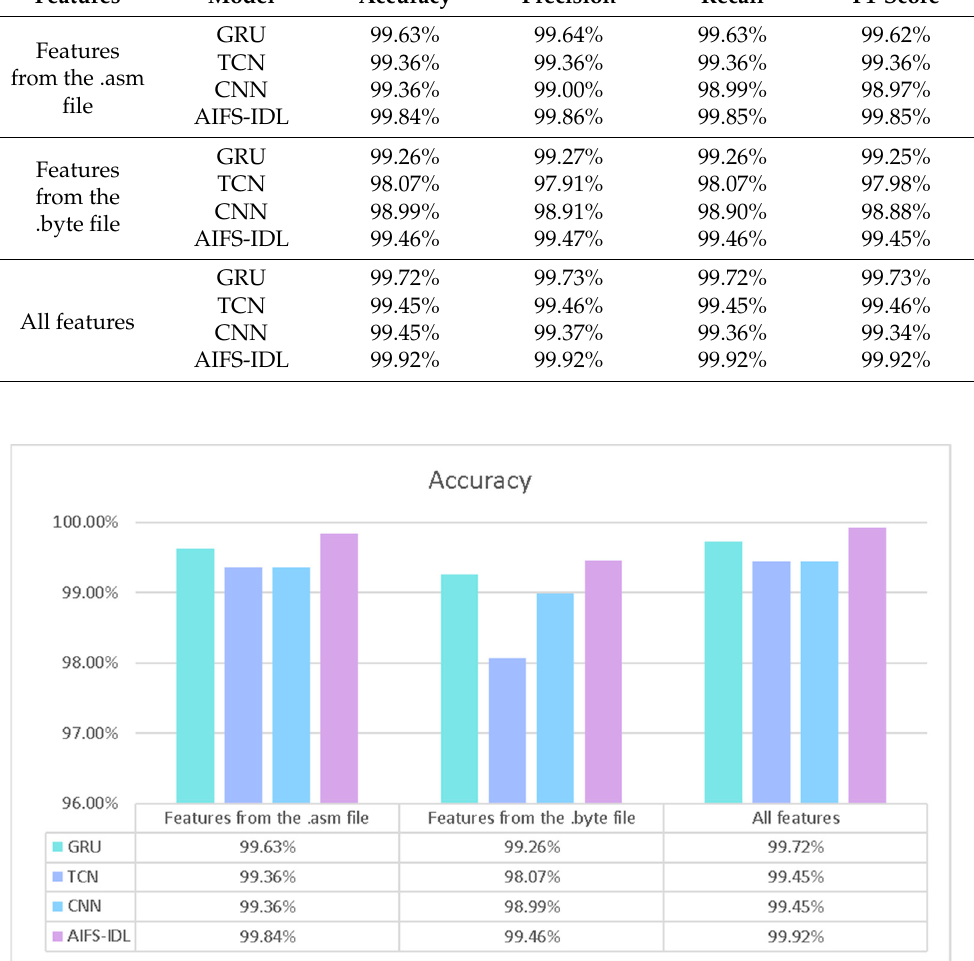
Figure 10. Accuracy of multi feature.